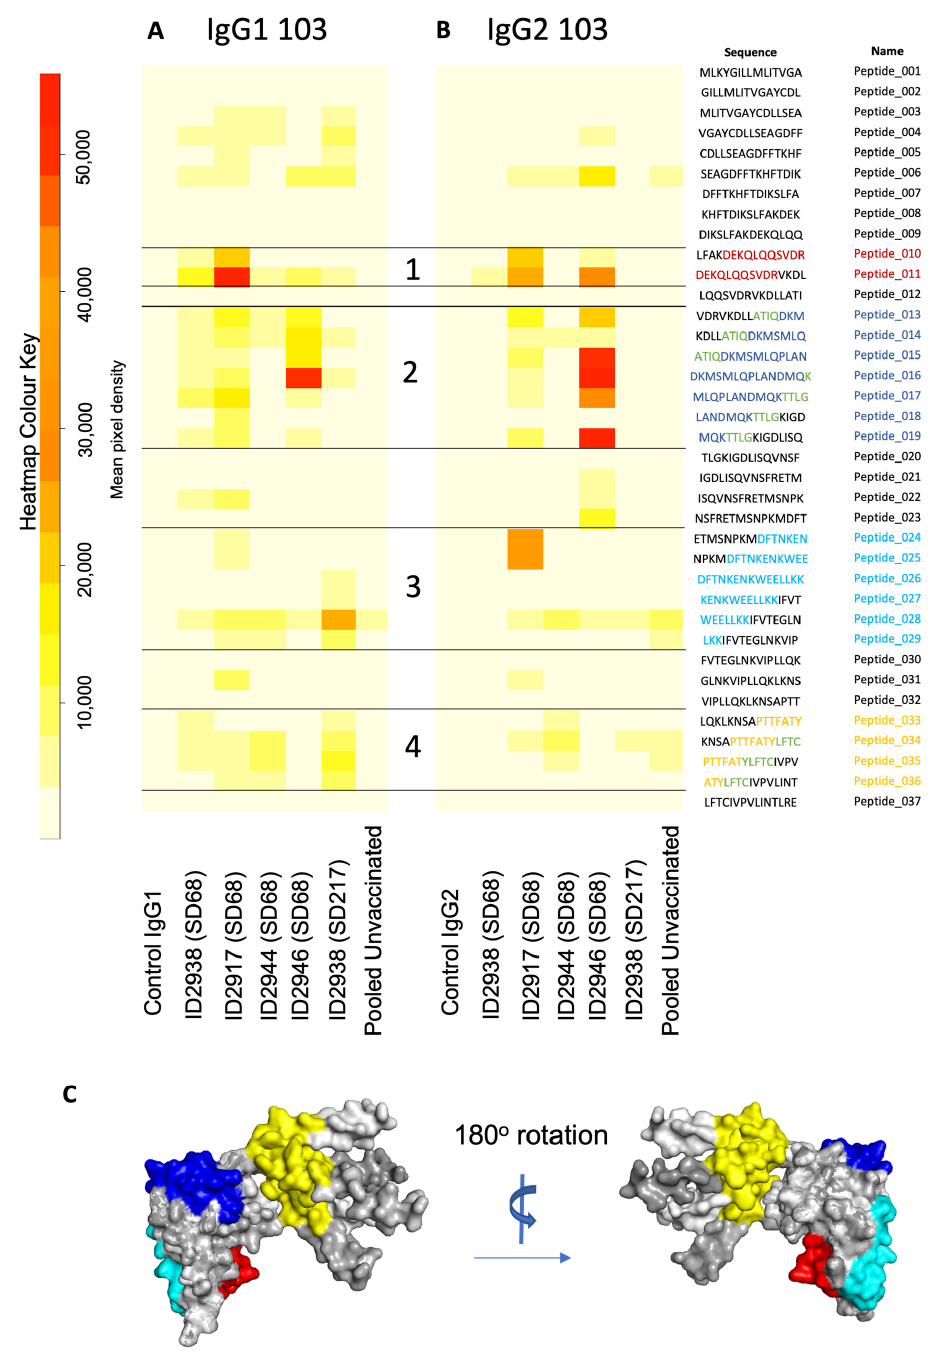
Figure 5. Peptide array heatmaps for IgG purified from IgG of animals vaccinated against Ov -103. Whole protein sequence divided into 37 overlapping peptides sequences 15 amino acids in length. Intensity of colour (white to red) shows degree of host antibody recognition (represented by mean pixel density) to ( A ) IgG1 and ( B ) IgG2. IgG controls (provided by JPT, lane 1) and anti-bovine IgG pooled from three unvaccinated, uninfected calves (lane 7) was included on each array, with purified serum IgG from individual vaccinated animals at one-week post-booster (SD62; 2938, 2917, 2944, 2946, lanes 2–5) and a single animal at 4 months post-exposure (SD215; 2938, lane 6). Putative epitopes recognised by IgG from vaccinated animals (1–4) were mapped onto a 3D model of Ov -103 using Alphafold2 [36] ( C ); Epitope 1 in red, epitope 2 in navy blue, epitope 3 in cyan and epitope 4 in